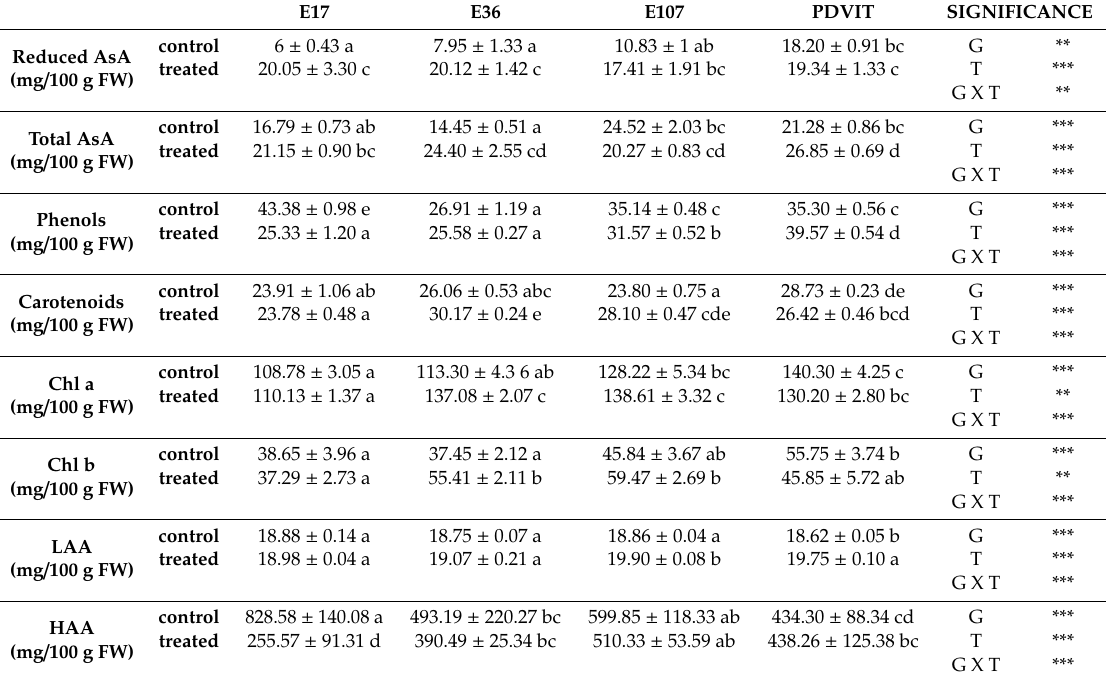
Table 2. Analyses of variance and mean comparison for reduced and total ascorbic acid (AsA), total phenols, carotenoids, chlorophylls a and b and total lipophilic and hydrophilic antioxidant activities (LAA and HAA, respectively) in leaves of di ff erent tomato cultivars treated with the biostimulant CycoFlow applied by fertirrigation four times. Means ± SD within rows and columns followed by the di ff erent letter are significantly di ff erent based on Tukey-HSD test ( p ≤ 0.05). E17 E36